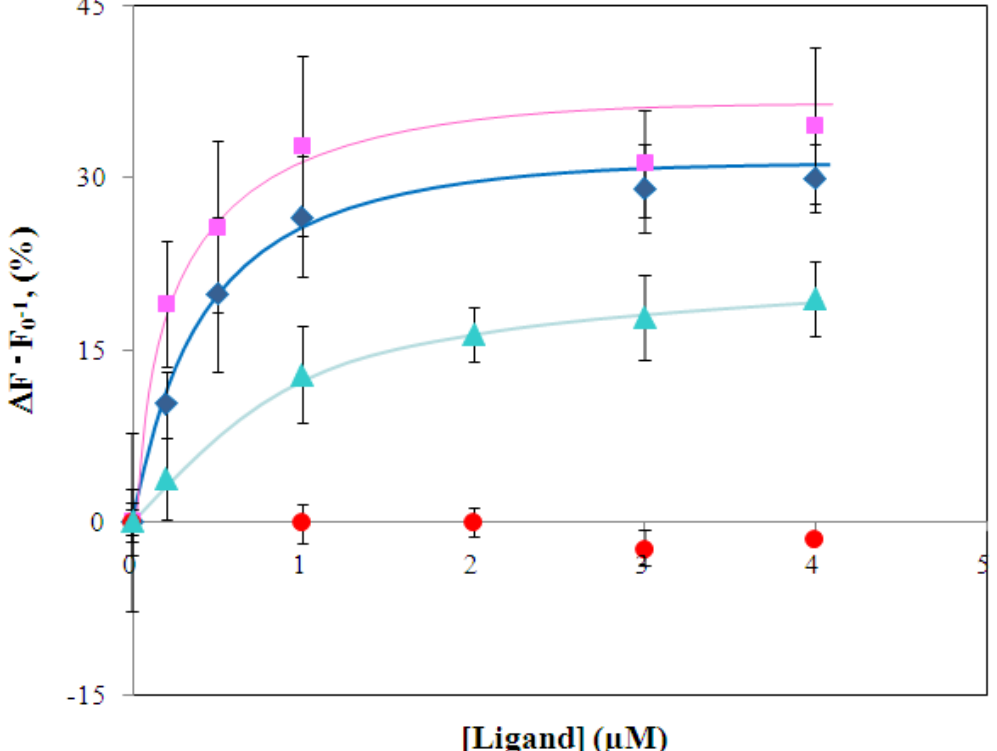
Figure 5. Effect of BCAAs and phenylalanine on the fluorescent intensity change of Gln149Cys- MIANS. The fluorescence intensity changes (at 434 nm) of MIANS-modified LIVBP at a final concentration of 0.4 µM were determined with different ligand concentrations; Leu (lozenge ♦ ), Ile (square ■ ), Val (triangle ▲ ), and Phe (circle ● ). Error bars indicate SD ( n